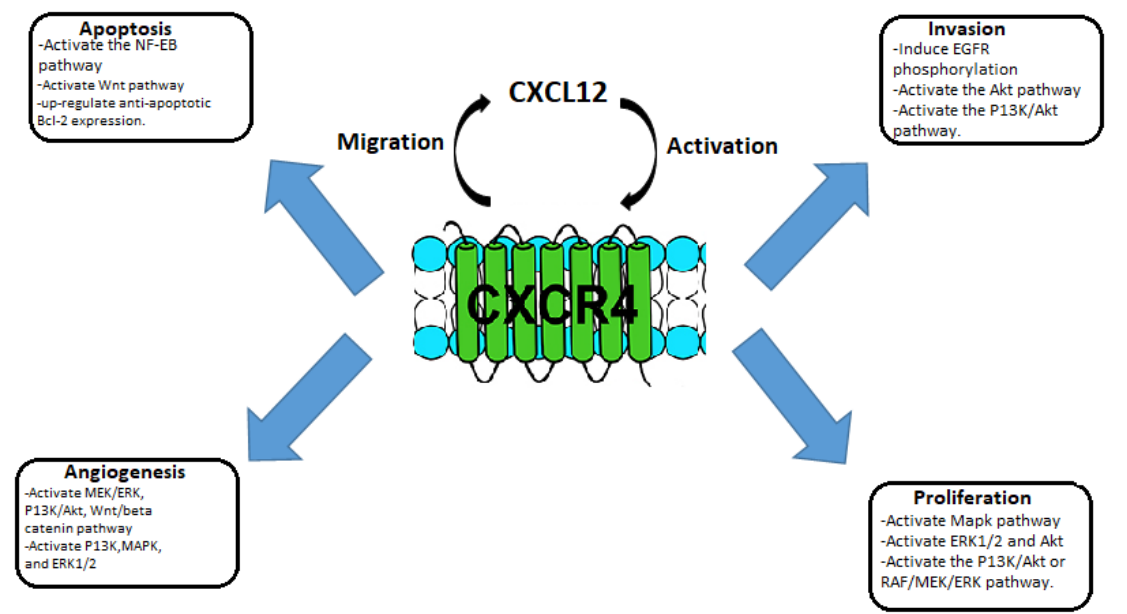
Figure 2. Schematic representation of the role of CXCL12/CCR4 in tumorigenesis and metastasis.